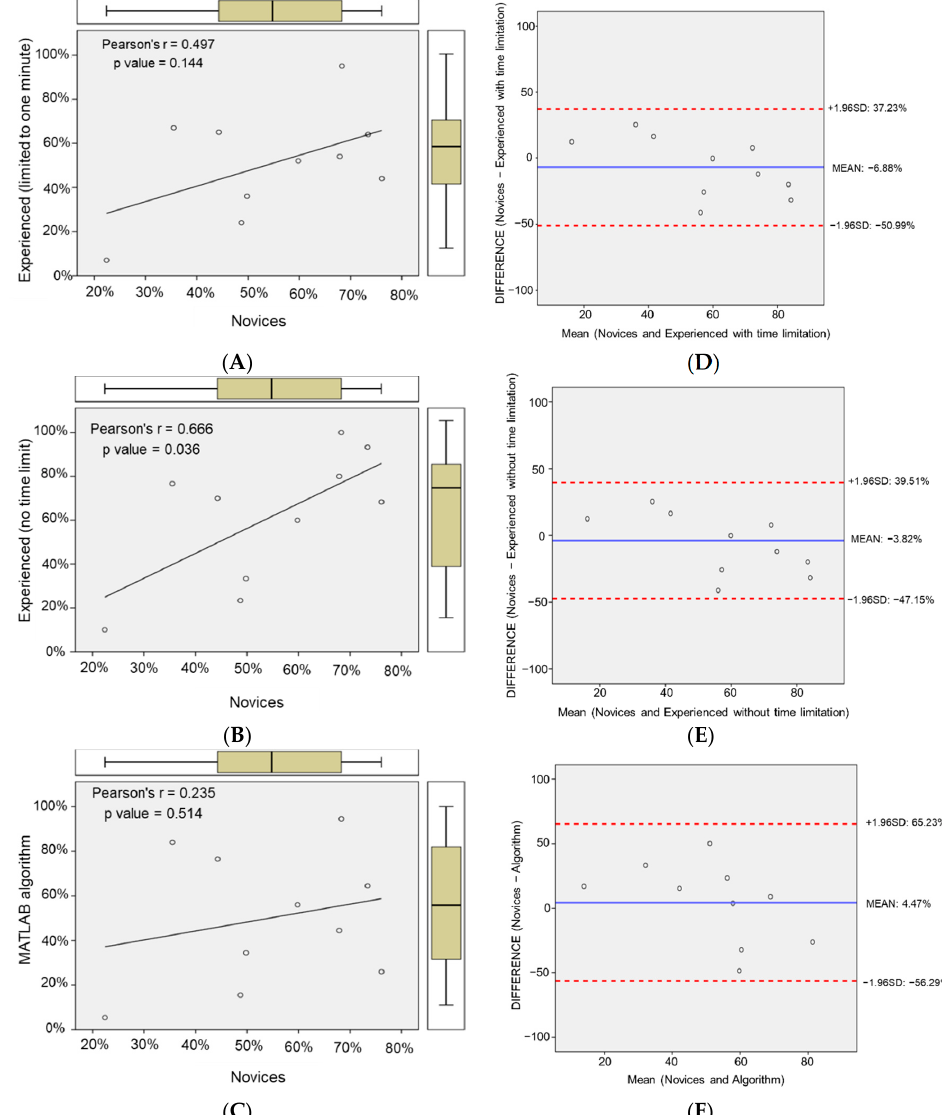
Figure 6. The correlations of the cell confluence levels measured by novice students and by ( A ) experienced researchers with a time limitation (examined the images in 1 min); ( B ) experienced researchers without a time limitation; and ( C ) the algorithm. Bland–Altman analysis for determining the 95% limit of agreement between ( D ) novices and experienced researchers with a time limitation (examined the images in 1 min); ( E ) novices and experienced researchers without a time limitation; and ( F ) novices and the algorithm.